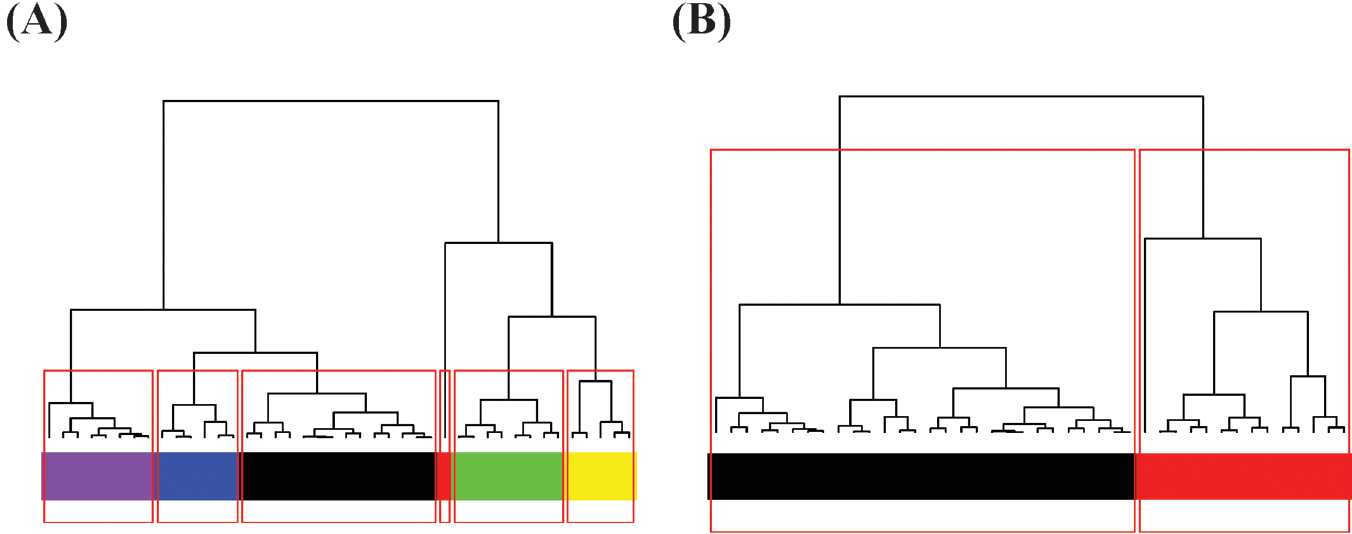
Fig 4. Response hierarchical clustering trees: (A) the fine-scale with 6 color-coded clusters; (B)the coarse-scale 2 color-coded clusters. It is intuitive that the task of successfully differentiating among the 6 fine-scale clusters of (A) would need much more covariate information than the task of differentiating between the two coarse- scale clusters of